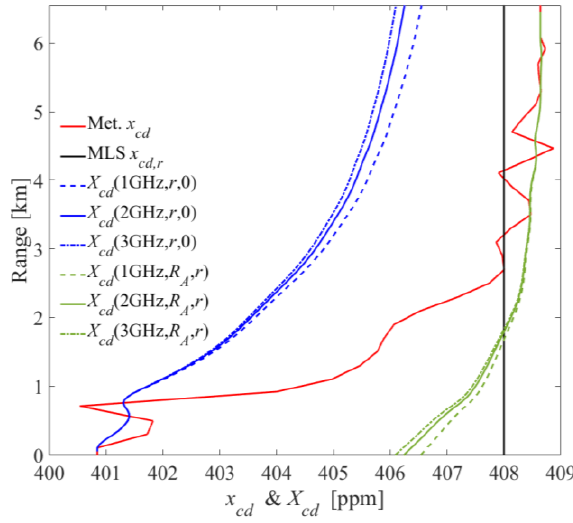
Figure 10. MGD and MLS CO 2 dry-air volume mixing ratio x cd profiles compared to modeling of X cd retrieval from the 2-μm IPDA lidar modeled measurements assuming perfect nadir operation. Range represents variable flight altitude for constant sea-level elevation (blue curves). Range represents variable ground elevation for a constant flight altitude of 6.5 km (green curves). Results obtained using MGD and modeled Δ τ cd , of Figures 8 and 9, respectively, for on-line wavelengths of 1, 2 and 3 GHz. The figure indicates small difference between x cd and X cd , independent of on-line wavelength, for shorter column length.